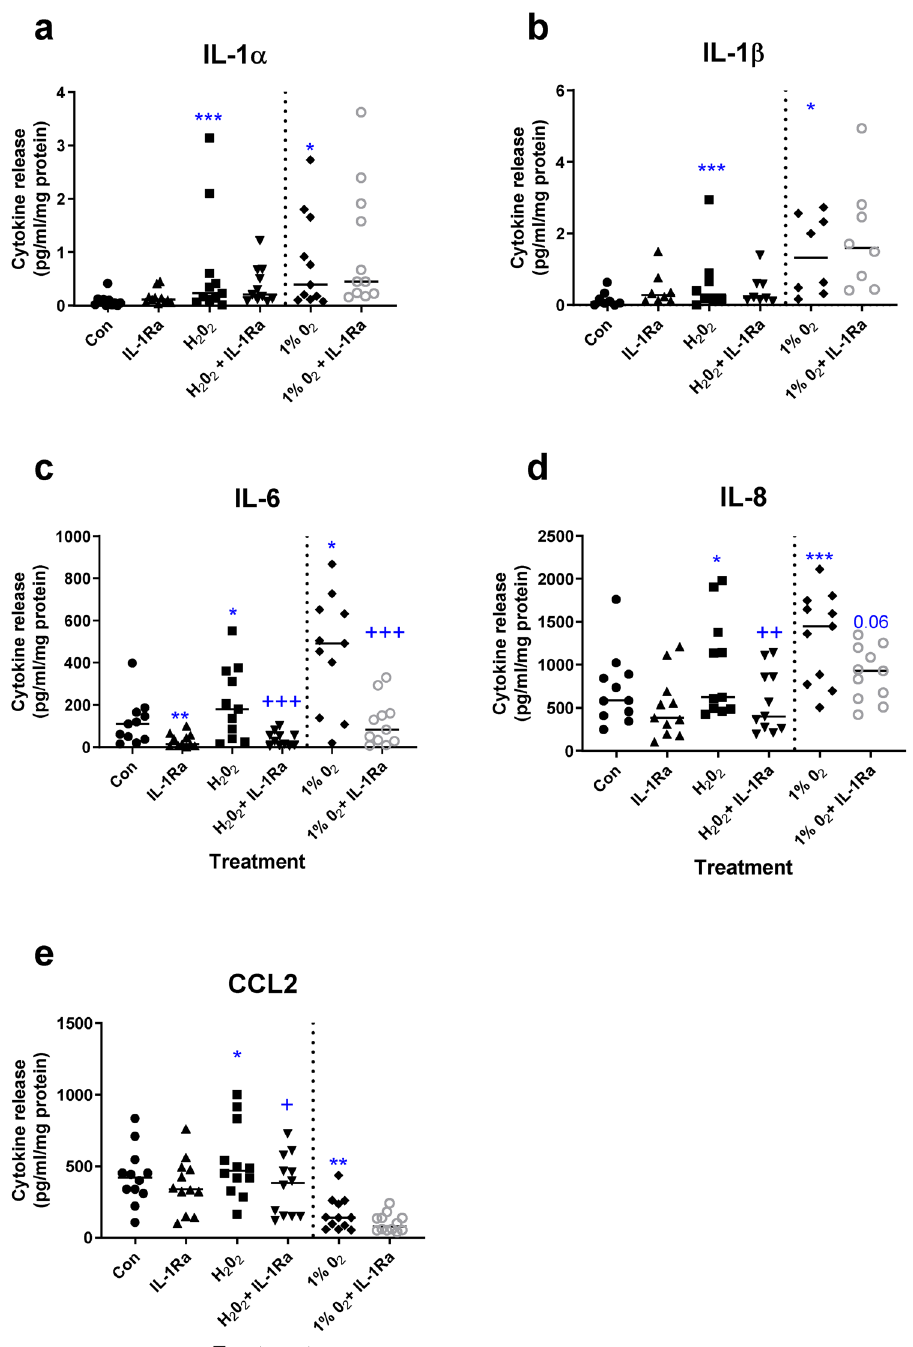
Figure 5. Effect of blockade of interleukin-1 (IL-1Ra) action on cytokine release from placental explants exposed to oxidative stress or hypoxia. Explants were exposed to oxidative stress (1 mM H 2 O 2 ), or hypoxia (1% O 2 ), in the presence or absence of IL-1 receptor antagonist (IL-1Ra). Cytokines were measured in conditioned medium: ( a ) IL-1α, ( b ) IL-β, ( c ) IL-6, ( d ) IL-8, ( e ) CCL2. Line represents median, n = 8–12. Asterisks represent significant differences compared to control (con) * p < 0.05, ** p < 0.01, *** p < 0.001. Plus signs represent significant differences compared to H2O2 or 1%O 2 alone + p < 0.05, + + p < 0.01, + + + p < 0.001. Friedman with Dunn’s multiple comparison